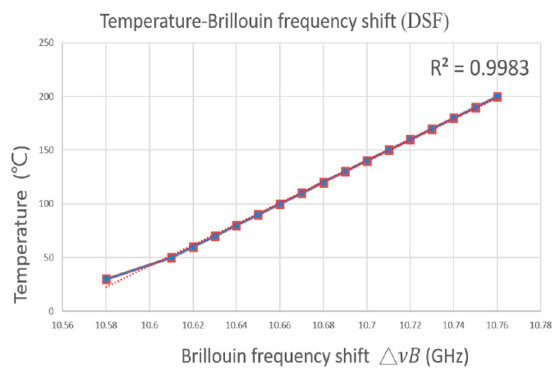
Figure 4. The fiber Brillouin frequency changes due to temperature variation.